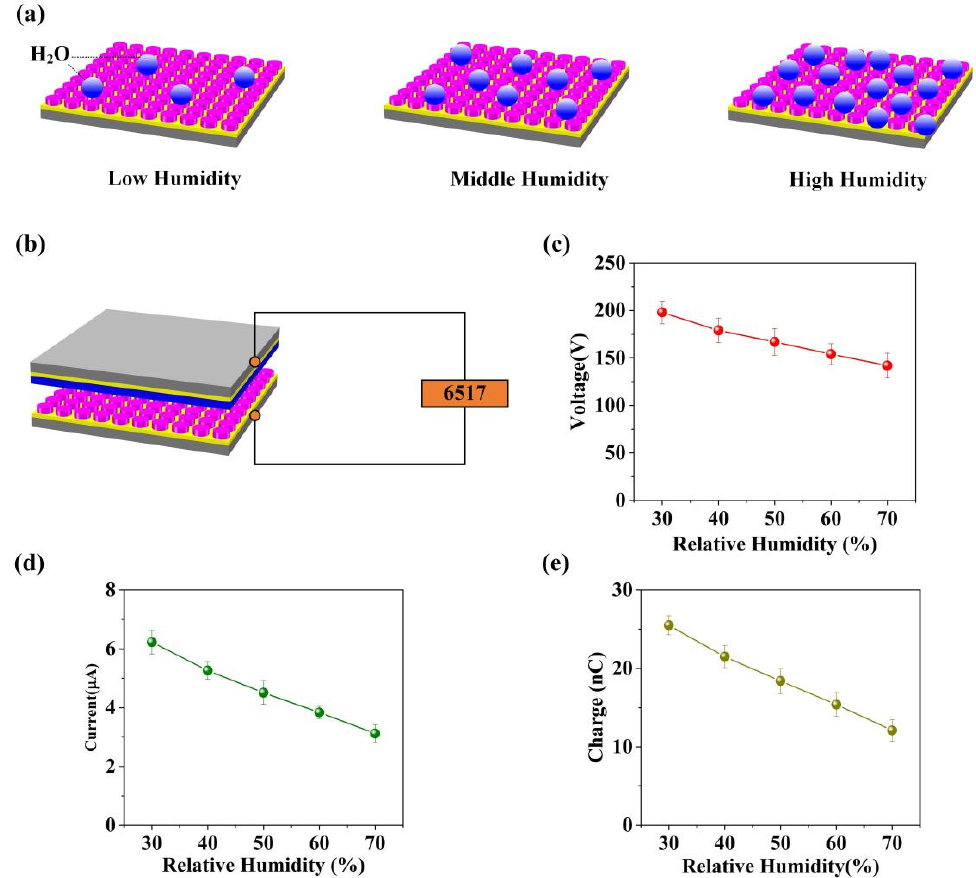
Figure 6. ( a ) The schematic illustration of the hygroscopicity for sodium chloride powder. ( b ) The relative humidity test system based on the S-TENG. ( c – e ) The electrical output of the S-TENG in different relative humidity conditions.